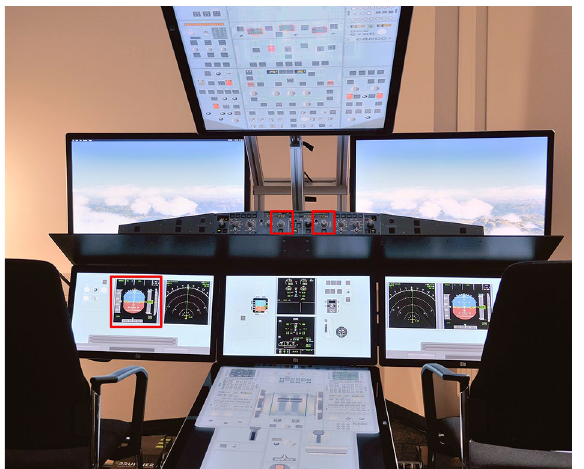
Figure 3. The iSim A321 cockpit. Primary flight display (left) and hardware panel with heading dial (centre left) and vertical speed dial (centre right) for required inputs are marked in